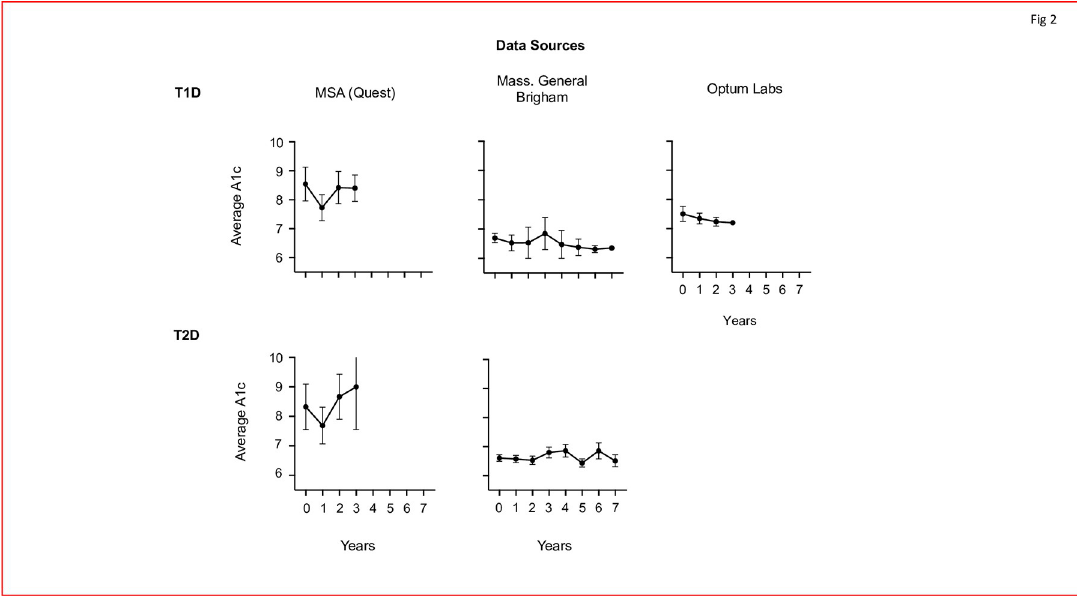
Fig 2. Decreasing trends in HbA1c are visible when using the average HbA1c for each dataset for T1Ds, but not T2Ds. In T1Ds, lower HbA1cs are seen for all three databases for subjects treated with BCG for bladder cancer. T2Ds on the other hand, do not show any trends post BCG instillation. N’s for each dataset; RPDR = 4, MSA = 9 and OL = 6 for T1Ds. And RPDR = 97, MSA = 9 for